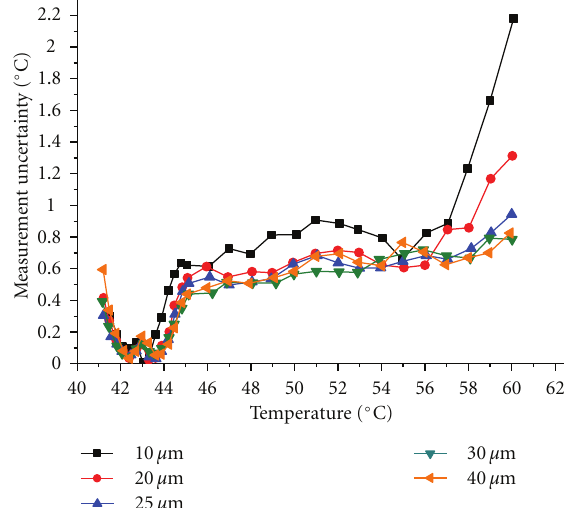
Figure 5: E ff ect of the lighting angle on the measurement uncer- tainty.